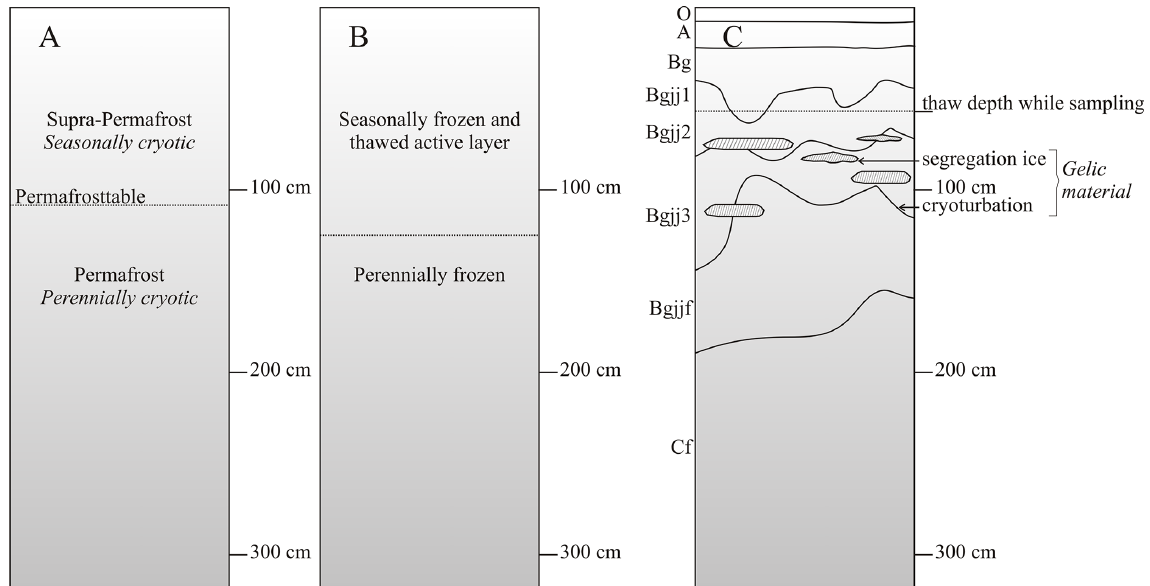
Figure 2. Schematic view of properties of permafrost-affected soils. (A) The soil thermal properties. The permafrost table divides the supra- permafrost (temperature can temporarily be higher than 0 ◦ C within two consecutive years) and the permafrost (temperature is at least two consecutive years lower than 0 ◦ C). (B) The freeze–thaw regime of the soils with the seasonally frozen and thawed active layer and the subjacent perennially frozen soil. (C) Example of a permafrost-affected soil profile. Cryoturbation and segregated ice ( gelic material according to US Soil Taxonomy; Soil Survey Staff, 2010) are